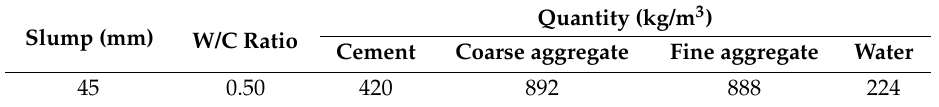
Table 2. Concrete mix design.